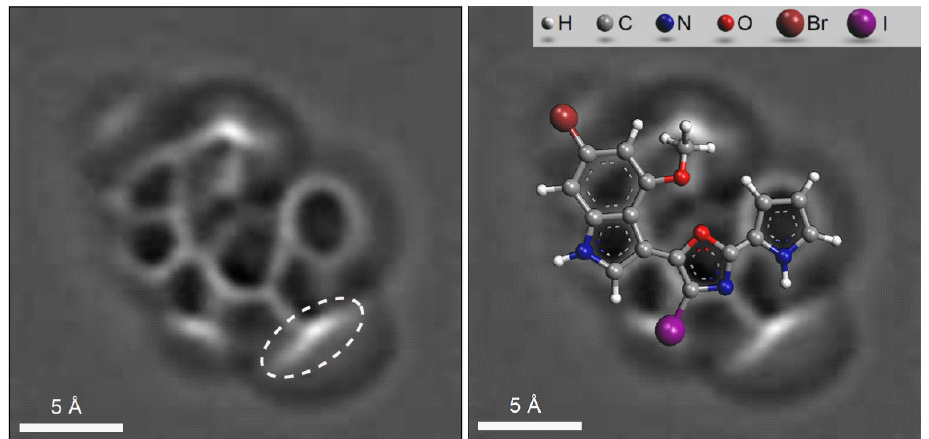
Figure 20. Molecule image ( left ) and superposition of the structure suggested by CASE on the image ( right ). The white encircled region marks an image artifact. This allowed the reliable assigning of the correct structure of breitfussin A. A posterior analysis showed that the 1 H- 13 C HMBC spectrum contained 11 NSCs (ten of them 4-bonds in length and one 5-bonds in length), which would have rendered the problem insolvable manually if only NMR data are used.